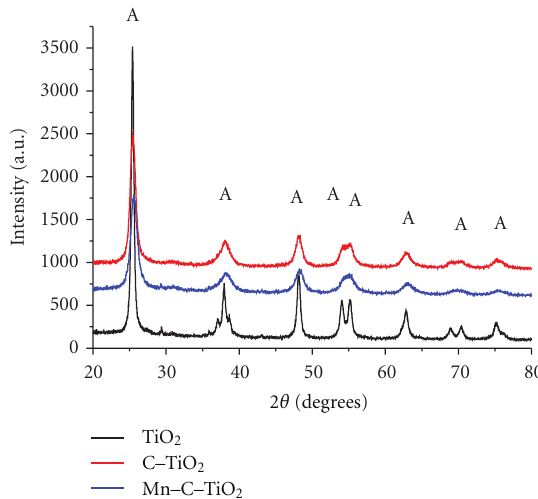
Figure 3: XRD patterns of as-prepared samples (A: